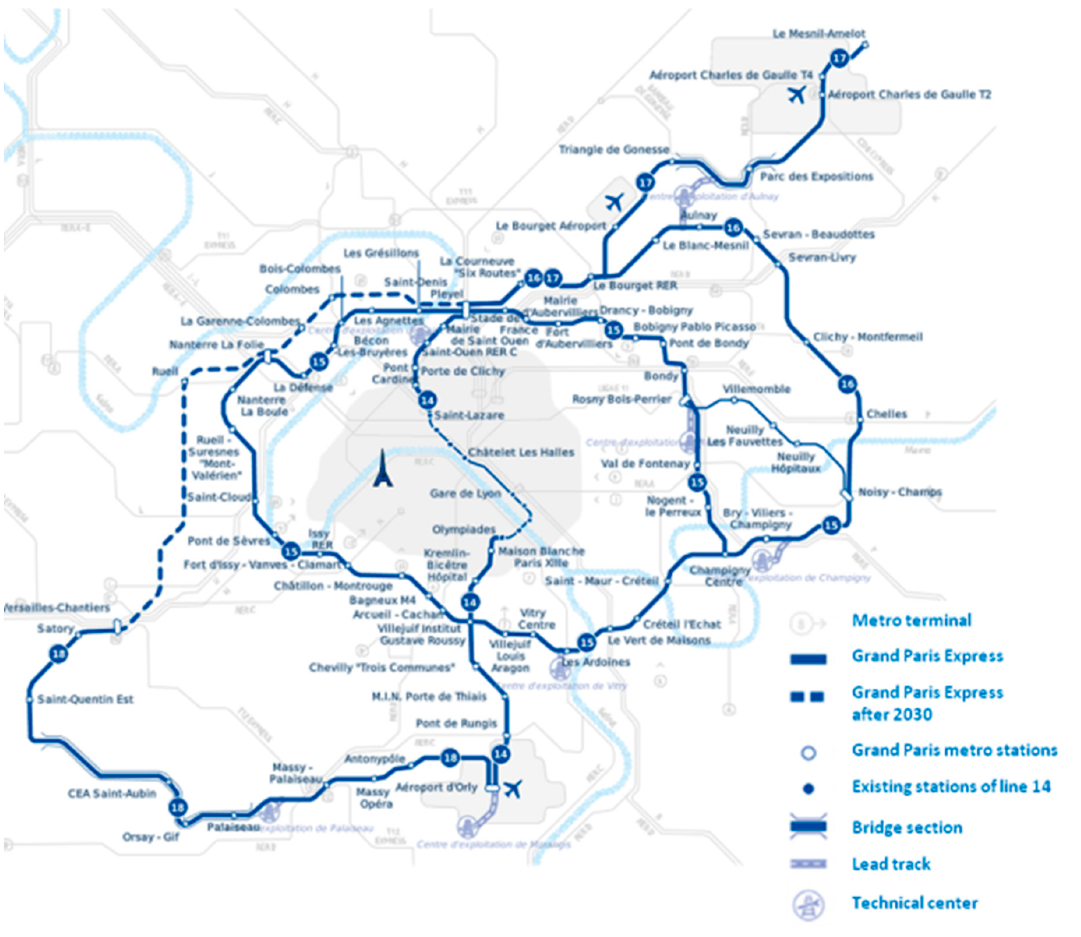
Figure 1. Projected Grand Paris Express subway network map